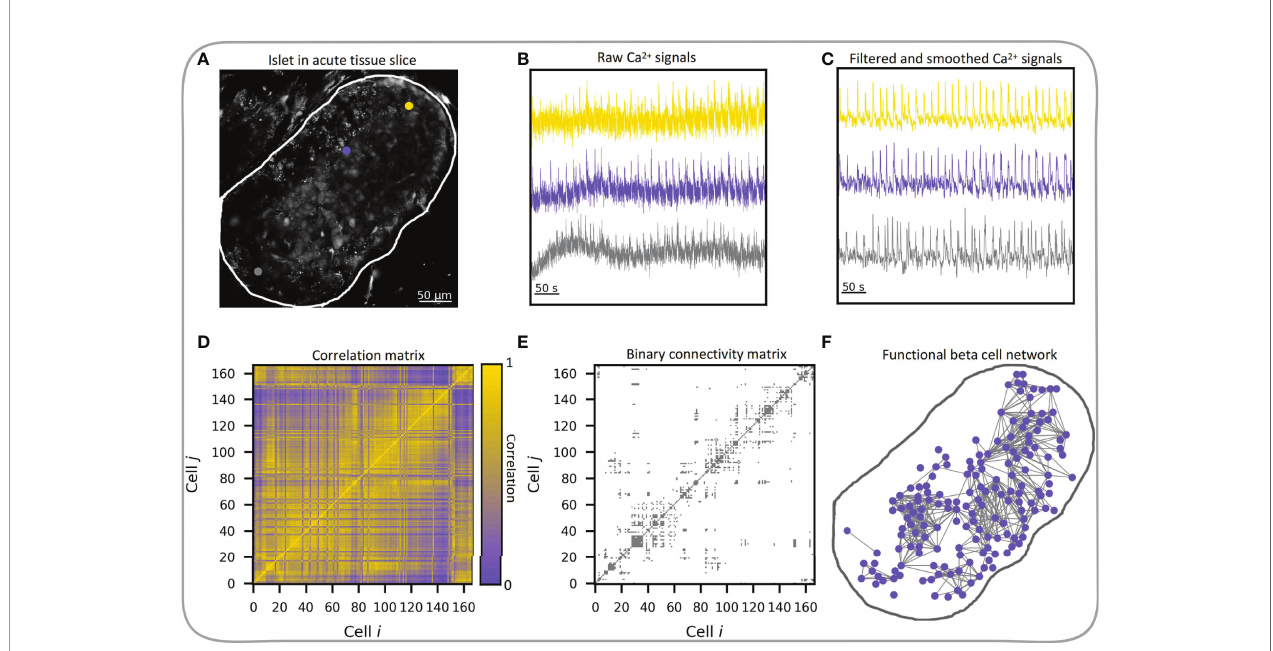
FIGURE 4 | Work fl ow of functional beta cell network extraction. (A) Confocal image of islet of Langerhans in acute tissue slice with three indicated beta cells (gray, yellow and violet dots) and indicated islet outline (white curve), exported raw Ca 2+ signals of the three beta cells (B) and processed Ca 2+ signals (C) of the same three cells. (D) Pearson correlation coef fi cient matrix based on fi ltered and smoothed Ca 2+ signals of all cell pairs in the islet. (E) Extracted binary connectivity matrix based on the thresholded correlation matrix; only cell pairs whose correlations exceeded R th = 0.82 were considered connected. (F) The corresponding functional beta cell network. Blue dots denote individual beta cells and gray lines represent functional connections between highly synchronized